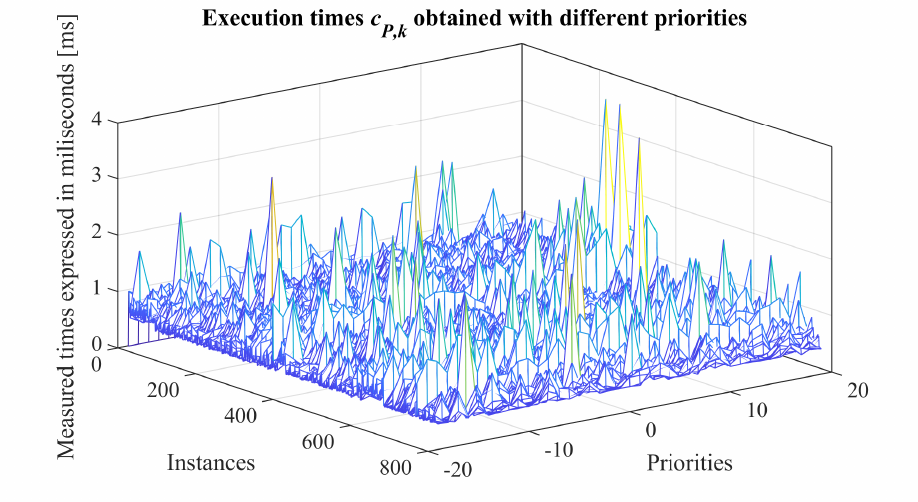
Figure 11. Execution times of the programmed real-time task using different priorities.